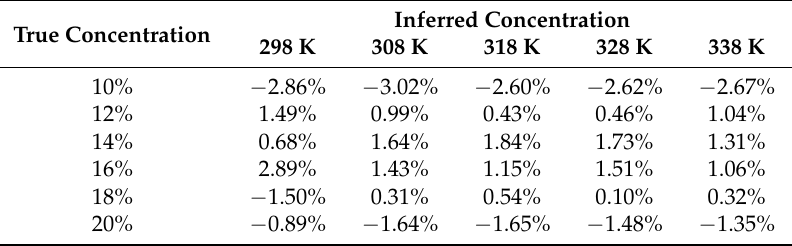
Table 4. The relative errors of wavelength modulation results after correction (298–338 K). True concentration